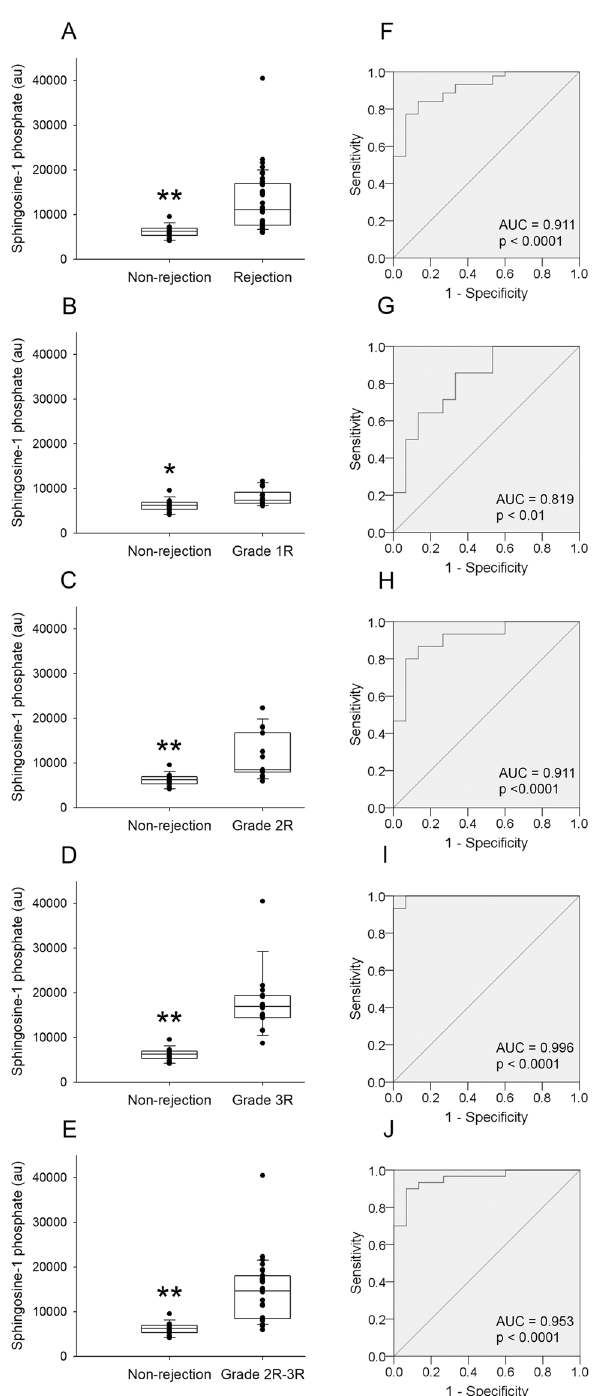
Figure 3. Circulating levels of S1P between non-rejection and rejection heart allografts and receiver-operating characteristic (ROC) curves. Comparison between non-rejection vs. all grades of rejection heart allografts ( A ). Comparison between the different grades of rejection heart allografts ( B , C , D ). Comparison between non- rejection vs. Grade 2 R and 3 R combined ( E ). The middle line in boxplots represents the median, the lower box bound the first quartile, the upper box bound the third quartile, the whiskers the 95% confidence interval of the fourth mean. ROC curve of circulating S1P for the detection of cardiac allograft rejection: All grades ( F ), Grade 1 R ( G ). Grade 2 R ( H ). Grade 3 R ( I ). Grade 2 R and 3 R combined ( J ). * p < 0.01, ** p <